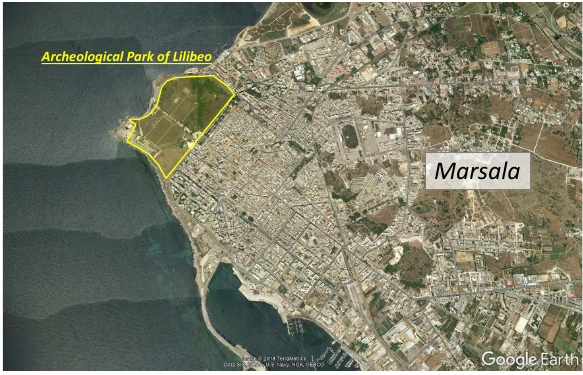
Figure 1. Archeological Park of Lilibeo (from Google Earth©).